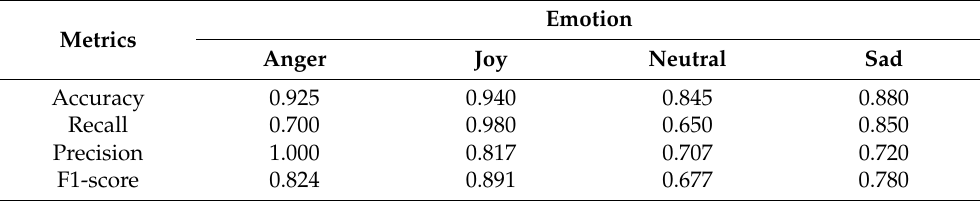
Figure 2. Confusion matrix of subjective evaluation of emotions in acting children’s speech in Russian language by Russian experts. Table 4. Per-class scores in multi-class classification, expert’s feature set with 16 samples in total.